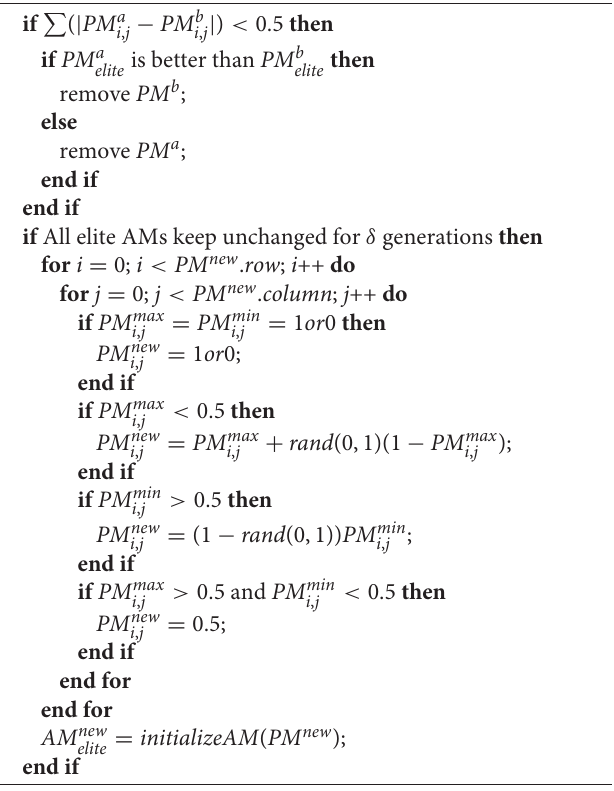
Algorithm 4 Adaptive Probability Matrix